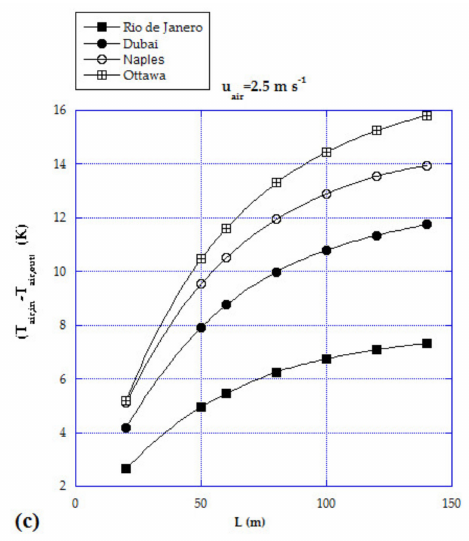
Figure 8. Temperature di ff erence between the inlet and outlet temperature of the air flowing in the GAHX, as a function of tube length in summer season for: ( a ) 1.5 m s − 1 ; ( b ) 2.0 m s − 1 ; ( c ) 2.5 m s − 1 velocity values.